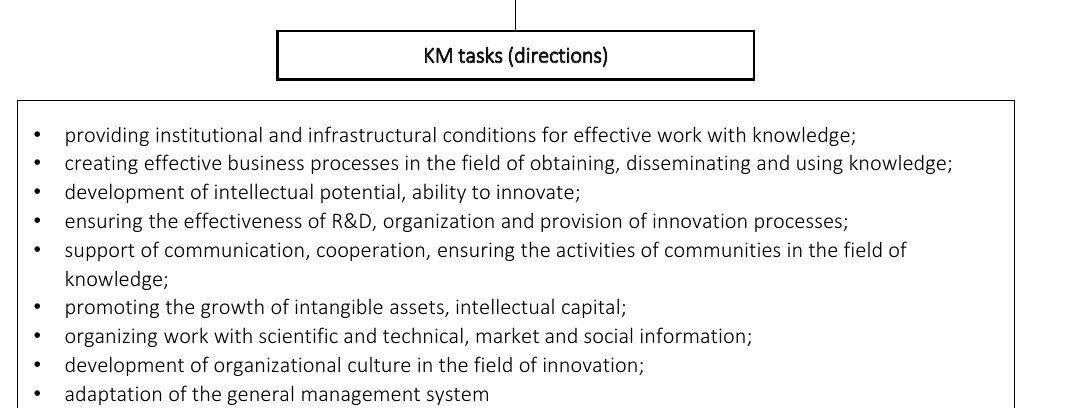
Figure 1. Goals, principles and tasks of